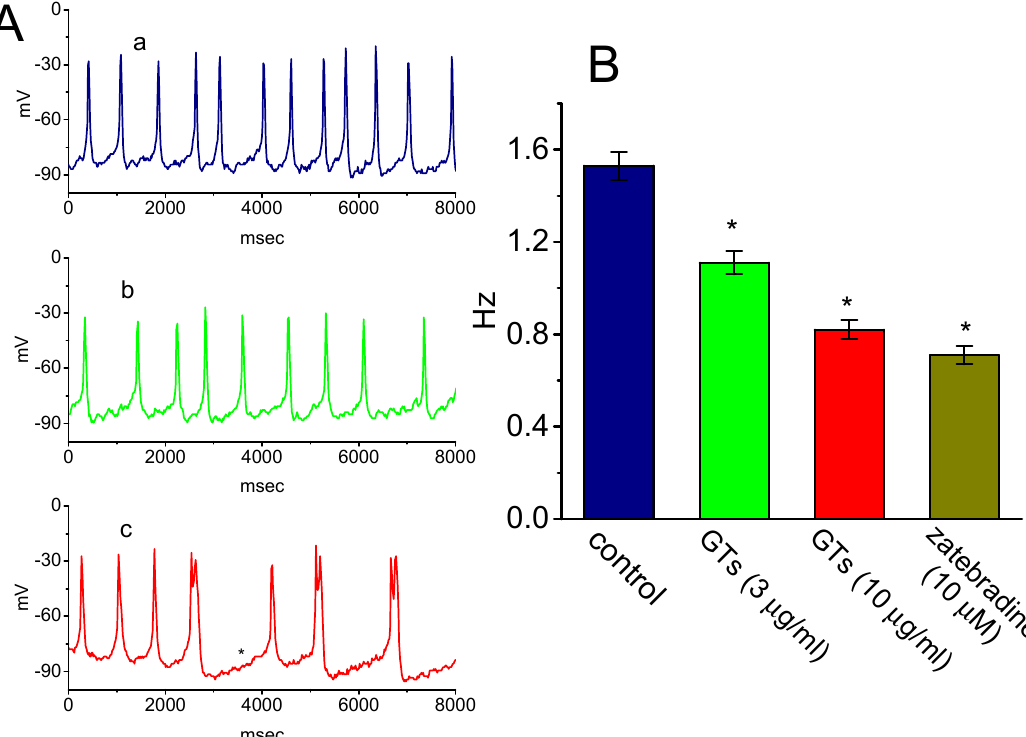
Figure 5. E ff ect of GTs on the firing of spontaneous action potentials (APs) in GH 3 cells. Cells were bathed in normal Tyrode’s solution containing 1.8 mM CaCl 2 , the pipette used was filled with K + -containing solution, and current-clamp voltage recordings were made. ( A ) Potential trace obtained in the absence (a) and presence of 3 µ g / mL GTs (b) or 10 µ g / mL GTs (c). The asterisk in potential trace labeled c indicates the depressed pacemaker potential. ( B ) Summary bar graph showing the e ff ects of GTs and zatebradine (10 µ M) on the firing frequency of spontaneous APs (mean ± SEM; n = 8 for each bar). *Significantly di ff erent from control ( p < 0.05).